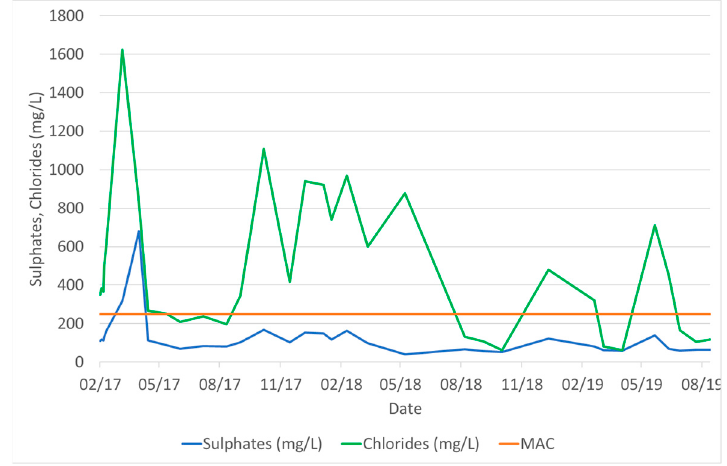
Figure 3. Concentrations of sulphates in the Boljkovac water supply facility (2017–2019) (MAC— maximum allowed concentration for chlorides and sulphates for drinking water).